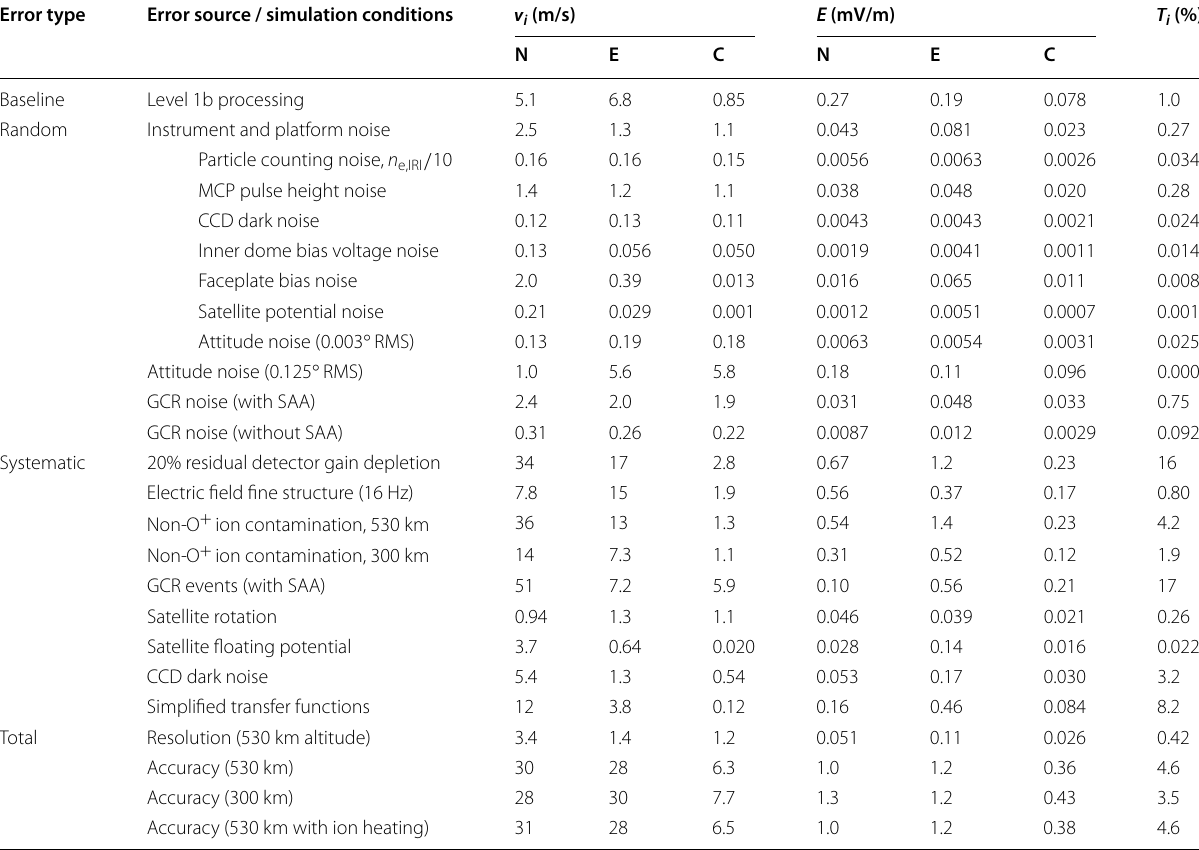
Table 2 Orbit-averaged EFI TII errors (1-sigma) estimated using the EES Error